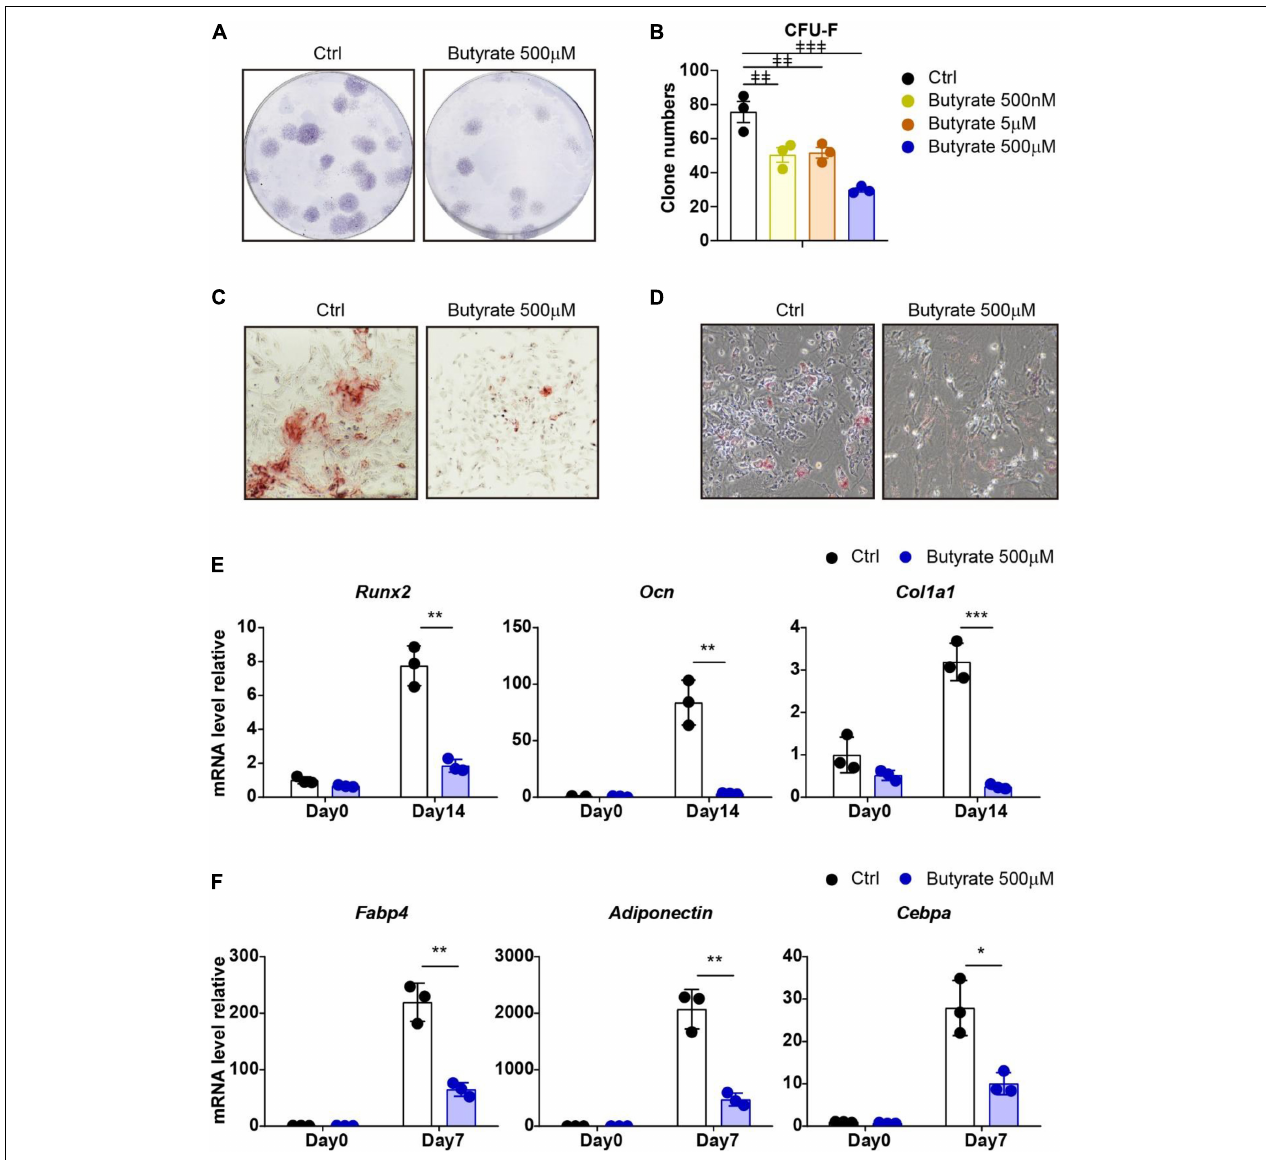
FIGURE 4 | Supplement of butyrate suppresses self-renewal and differentiation potential of MSCs. (A) Representative wells of CFU-F colonies stained with crystal violet (5 × 10 5 bone marrow cells were initially plated). (B) CFU-F colony numbers after butyrate treatment as indicated doses or with vehicle control treatment as indicated (5 × 10 5 bone marrow cells were initially plated). (C) Osteogenic differentiation of MSCs with or without butyrate treatment. Alizarin red S staining of MSCs cultured in osteogenic differentiation medium at day 14. (D) Adipogenic differentiation of MSCs with or without butyrate treatment. Oil Red O staining of MSCs cultured in adipogenic differentiation medium at day 7. (E) Quantitative RT-PCR of transcript levels of osteogenic genes (normalized to day 0 control group). (F) Quantitative RT-PCR of transcript levels of adipogenic genes (normalized to day 0 control group). Repeated-measures one-way ANOVA followed by Dunnett’s test for multiple comparisons in (B) . p < 0.01, p < 0.001. Two-tailed Student’s t tests were used to assess statistical significance in (E,F) . * p < 0.05, ** p < 0.01, *** p <